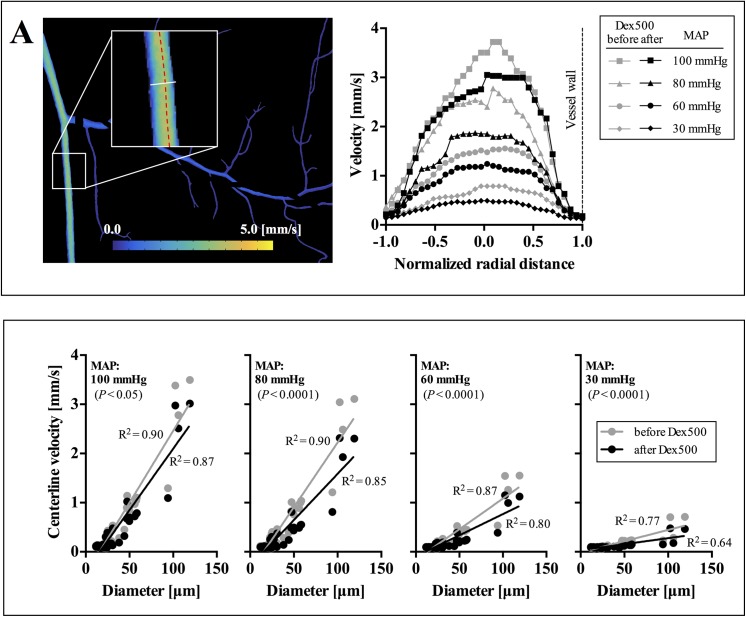
Typical example of velocity profile and distribution in the venular network.
A: Representative velocity profiles at various MAPs in a venule (ID ~95 μm). B: Centerline velocity as a function of vessel diameter at various MAPs (total 55 vessel segments). Data were obtained from the single venular network shown in A. Solid lines represent the linear regression fits. P-values represent the statistical significance in the difference between the slopes of regression lines before and after dextran infusion.